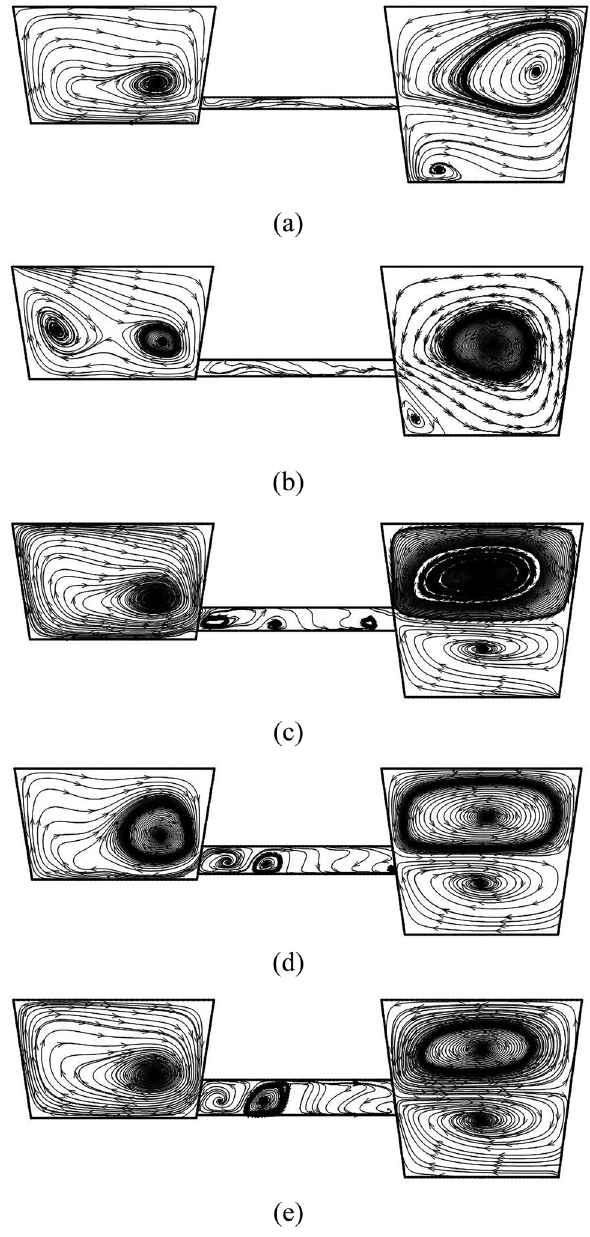
Figure 4: Streamline at longitudinal section through the center of the channel. ( a ) d = 100 mm, ( b ) d = 150 mm, ( c ) d = 200 mm, ( d ) d = 250 mm and ( e ) d = 300